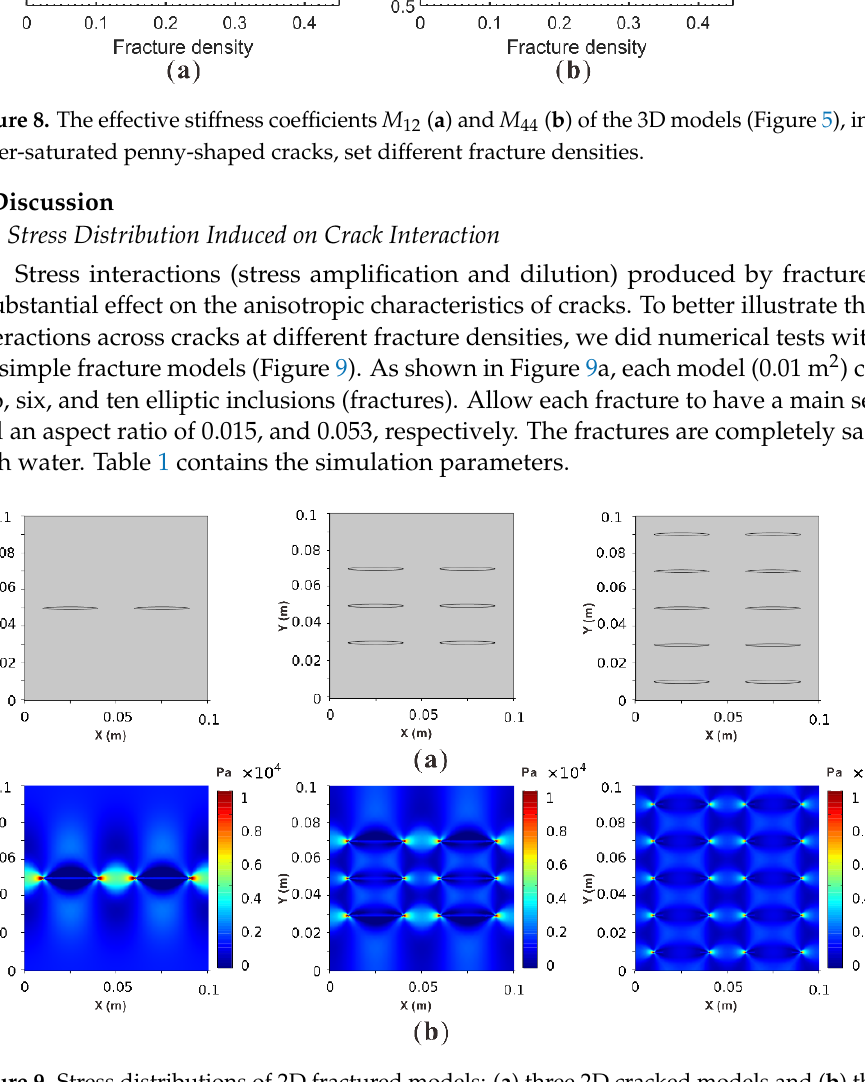
Figure 8. The effective stiffness coefficients M 12 ( a ) and M 44 ( b ) of the 3D models (Figure 5), including water-saturated penny-shaped cracks, set different fracture densities.